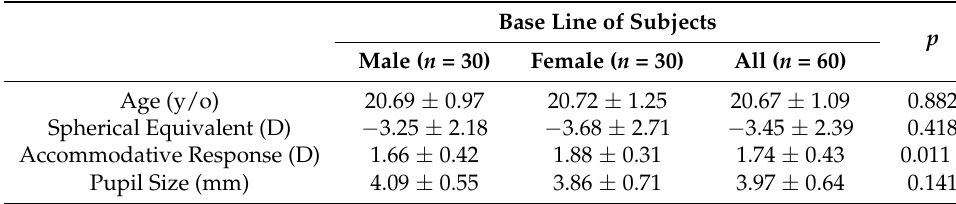
Table 1. The base line of the 60